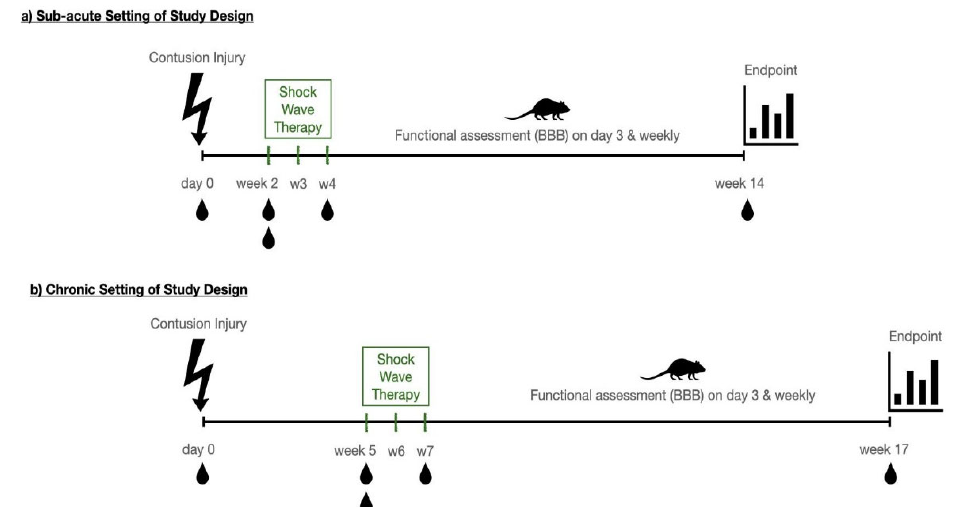
Figure 1. Study Design. In this study, two different timepoints were chosen to apply the shockwave therapy. Initially, a contusion injury was inducted upon laminectomy. In the subacute setting ( a ), therapeutic shockwaves were applied for three consecutive weeks, starting at week 2 after injury. In the chronic setup ( b ), the same treatment paradigm was applied starting at week 5. In both setups, the observation period until the end point was 10 weeks following the last therapeutic session. Throughout this period, functional assessment of motor function and regeneration using the BBB- Score (Basso, Beattie and Bresnahan locomotor score) was determined on day 3 and subsequently every week. Serum sampling for miRNA analysis, indicated by the schematic blood drop, was conducted prior to injury, prior to the first shock wave application, 1 h after the first wave application, immediately after the last shock wave application and at the end